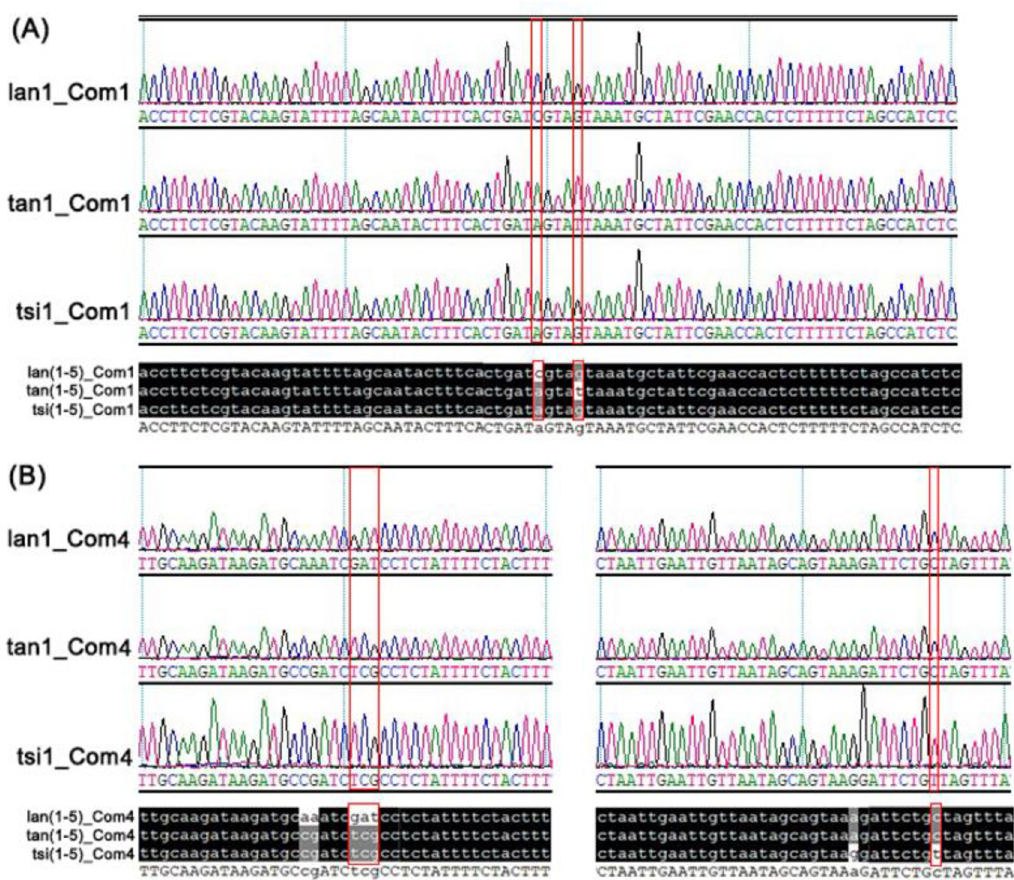
Fig 8. The alignment of the sequencing chromatogram of the PCR products was amplified using the primers of Com1 and Com4. The ID of each sequence is shown on the left side of each panel. The composition of the ID in turn includes the abbreviation of the species name, plant individual id, and primer name. The figure of alignment represents the individuals 1–5 of three species. The sequencing chromatogram of the PCR products amplified takes individual 1 of three species as an example. The red squares represent the SNP and Indel regions, which can distinguish the three species. The nucleotides identical across all plastomes are shaded in black, whereas those conserved in 60% of the sequences are shaded in gray. lan: Codonopsis lanceolata ; tan: Codonopsis pilosula subsp. tangshen ; tsi: Codonopsis tsinlingensis . Arabic numerals represent the individual 1.